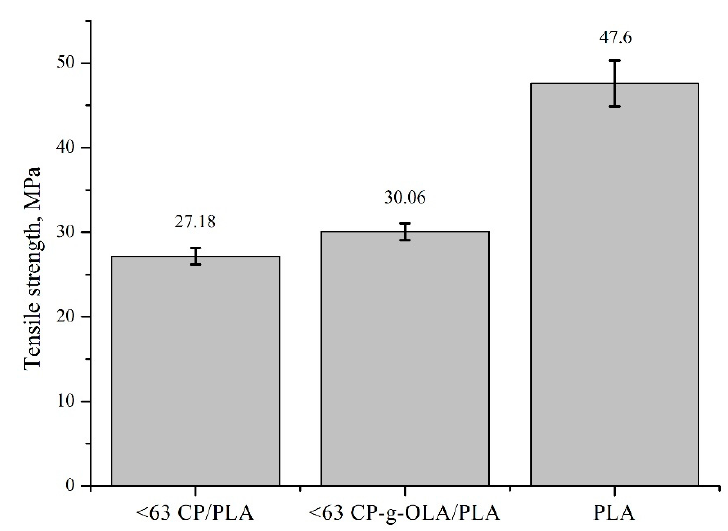
Figure 9. Tensile strength of neat PLA, <63 CP/PLA and <63